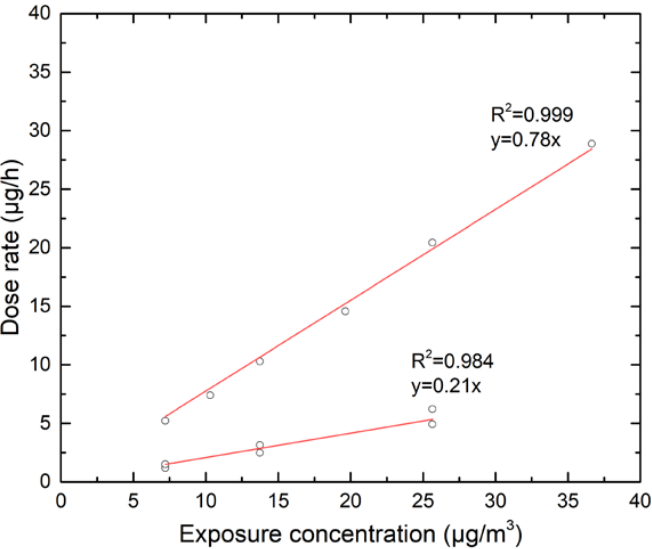
Figure 4. Correlation between exposure concentration (μg/m 3 ) and deposited dose rate (μg/h). The red lines represent linear regression between the variables.